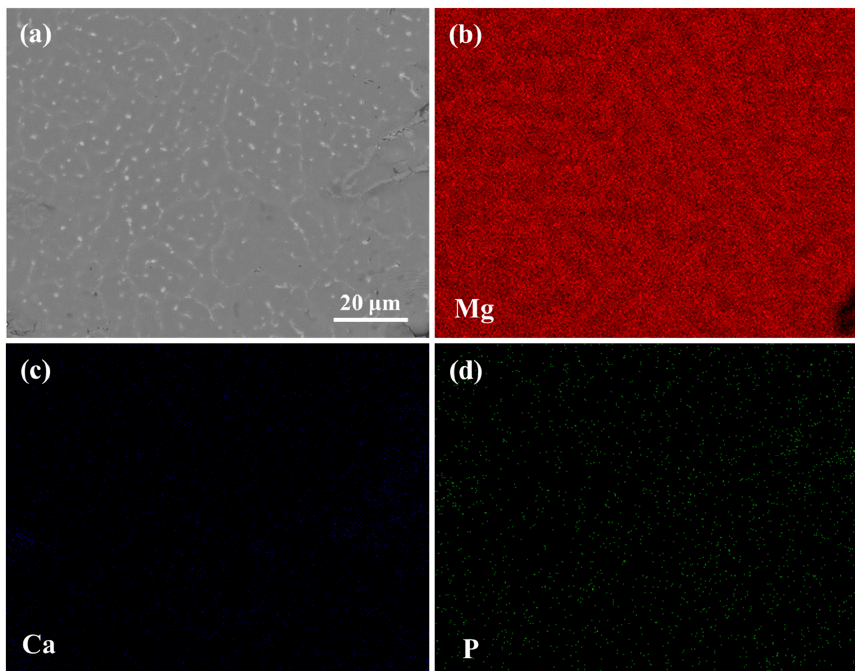
Figure 3. The scanning electron microscopy (SEM) observation and energy dispersive